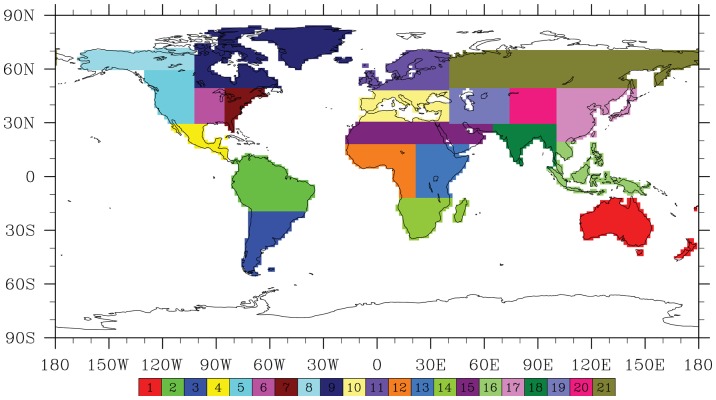
Map of 21 regions.